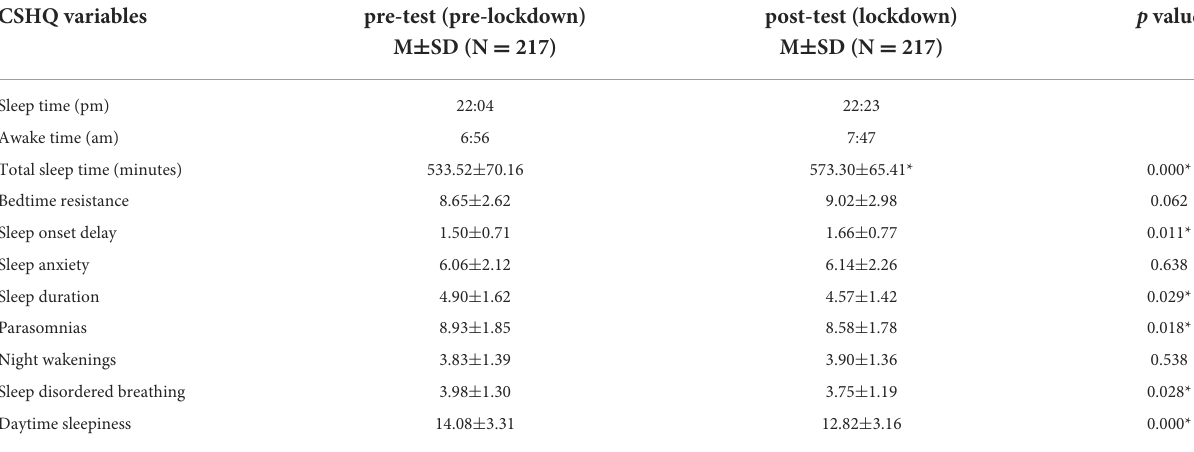
TABLE 1A Comparison of CSHQ during the lockdown and pre-lockdown periods. CSHQ variables